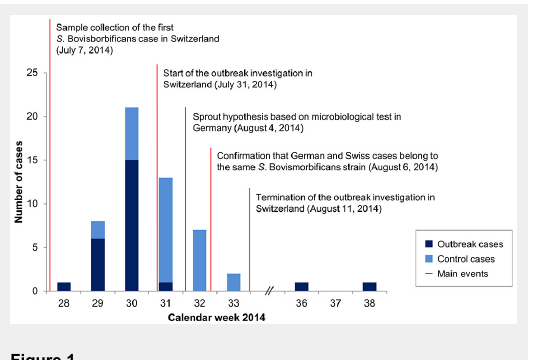
Epidemiological profile and main investigation events for the Salmonella Bovismorbificans outbreak, July–September 2014,